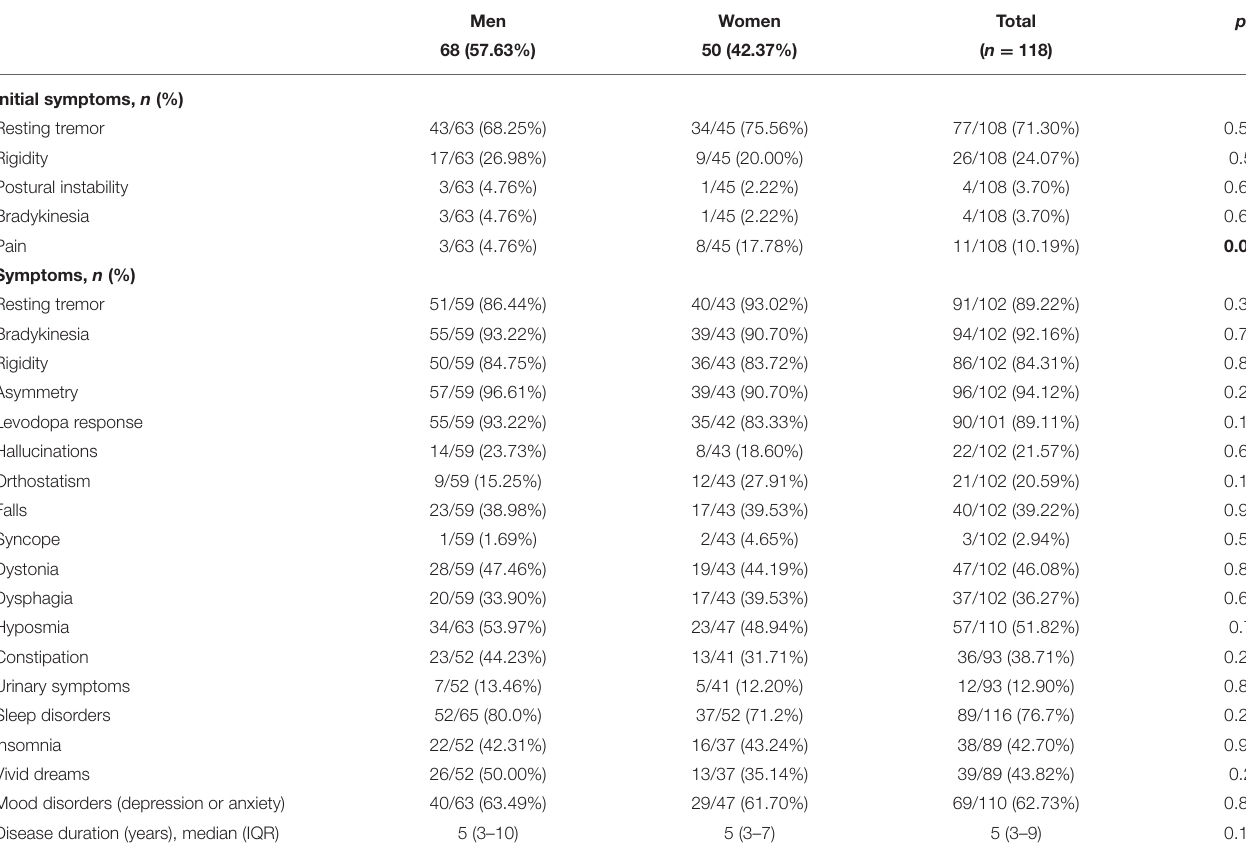
TABLE 2 | Clinical manifestations of PD cases, with sex